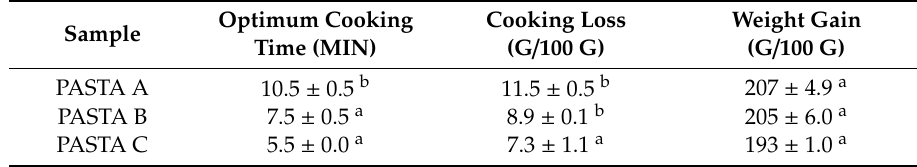
Table 3. Cooking quality of the three types of pasta.